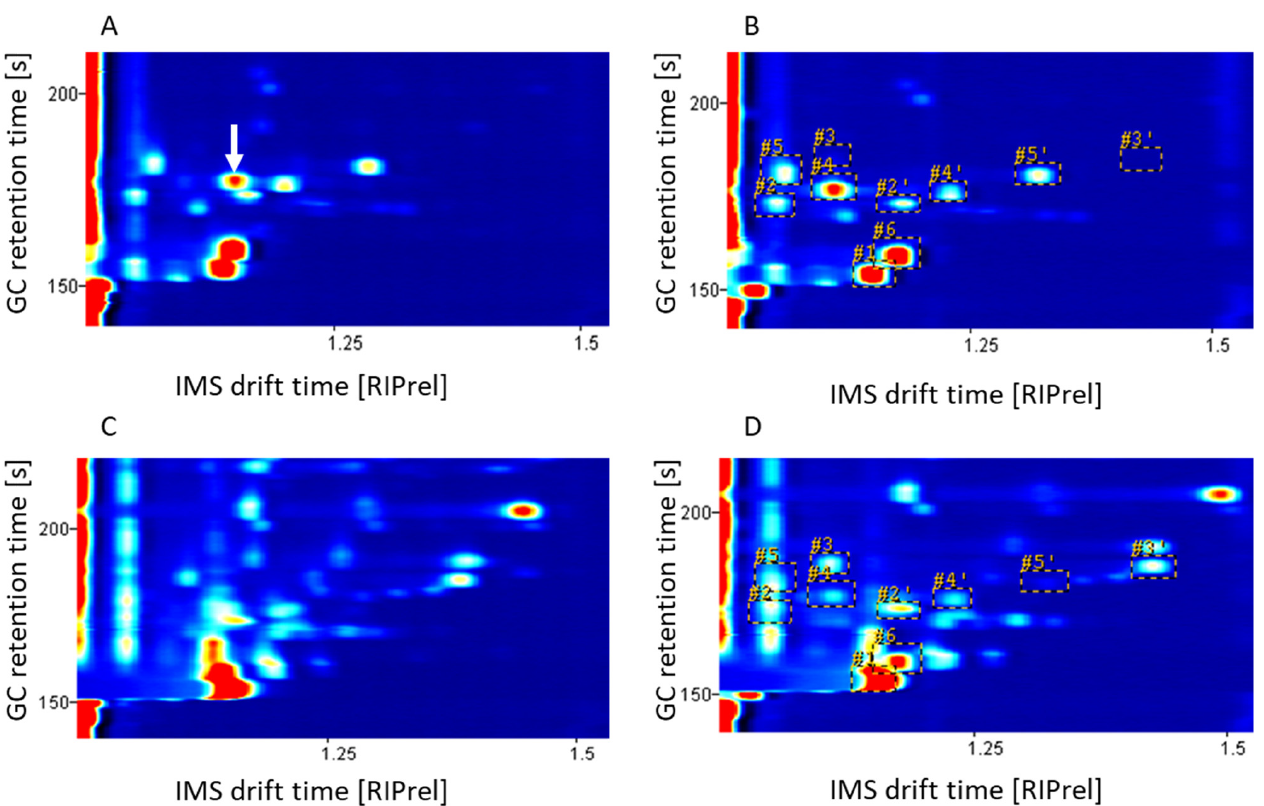
Figure 1. Temperature shift in prototypic high-temperature ion mobility spectrometer (HTIMS). ( A ) Commercial kefir at HTIMS cell temperature 90 °C, ( B ) commercial kefir at HTIMS cell temperature 120 °C, ( C ) traditional kefir LS (48 h) at HTIMS cell temperature 90 °C, and ( D ) traditional kefir LS (48 h) at IMS cell temperature 90 °C. Identified substances: #1, ethanol; #2, acetic acid; #3, ethyl acetate; #4, diacetyl; #5, 2-butanon; and #6, acetone. The arrow marks the diacetyl peak in close proximity to the acetic acid peak (#2 ′ ).